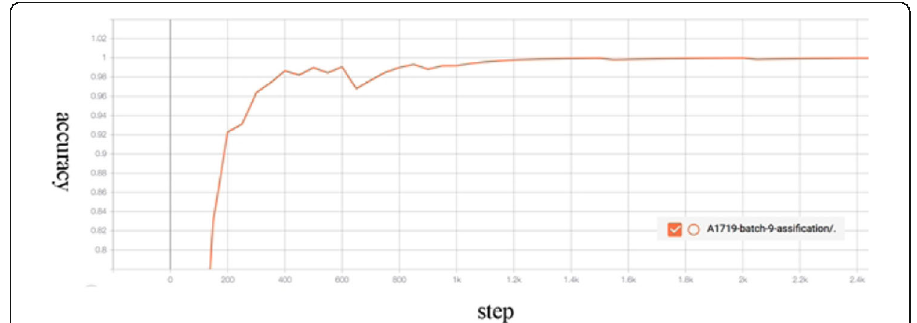
Fig. 18 Training accuracy of classification into 9 individual chips